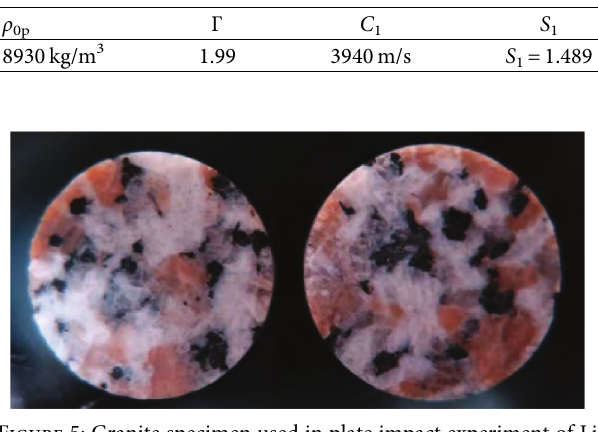
Figure 4: Design of plate impact modeling. (a) Parameters of the flyer and the target. (b) The model in AUTODYN-2D. Table 2: Parameters of Gr¨uneisen equation for copper [20].